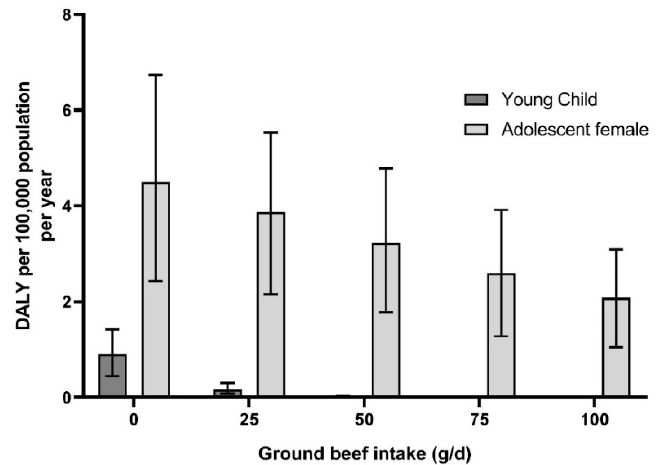
Figure 2. Estimated number of DALY from iron deficiency anemias in France for young children (three to six) and adolescent females (15–17) according to ground beef consumption scenarios. Results expressed per 100,000 individuals per year. Full lines represent the 95% uncertainty around the mean value.